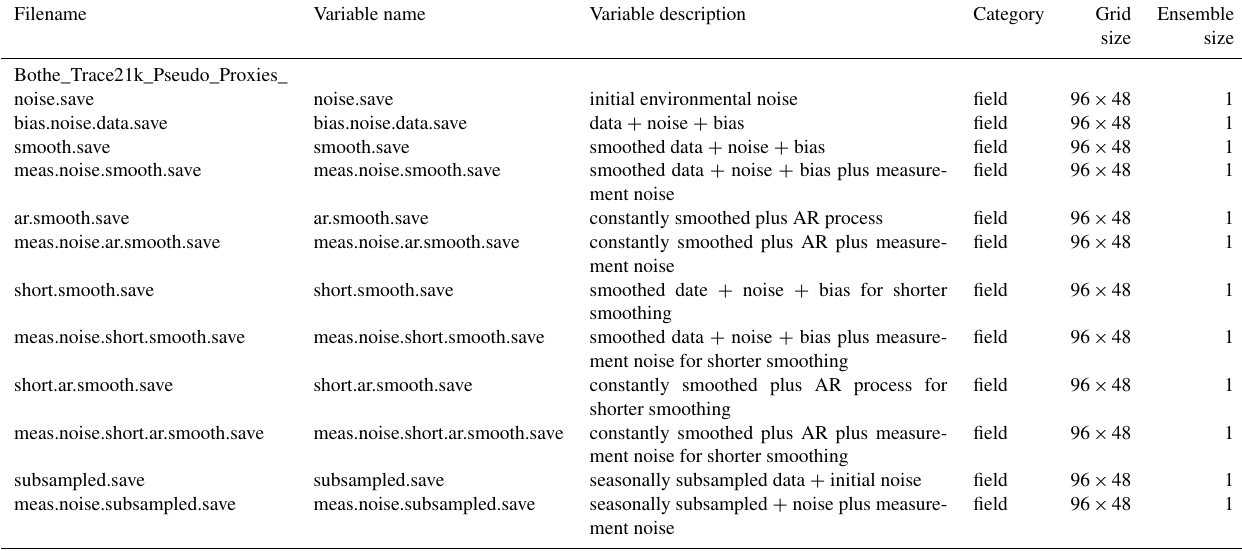
Table 1. List of files provided, the variables included, their description, the category (full surrogate proxy field, essence field, or ensemble), and size of the ensemble. All files have the same stem Bothe_Trace21k_Pseudo_Proxies_ and the ending _annual.nc. Filename Variable name Variable description Category